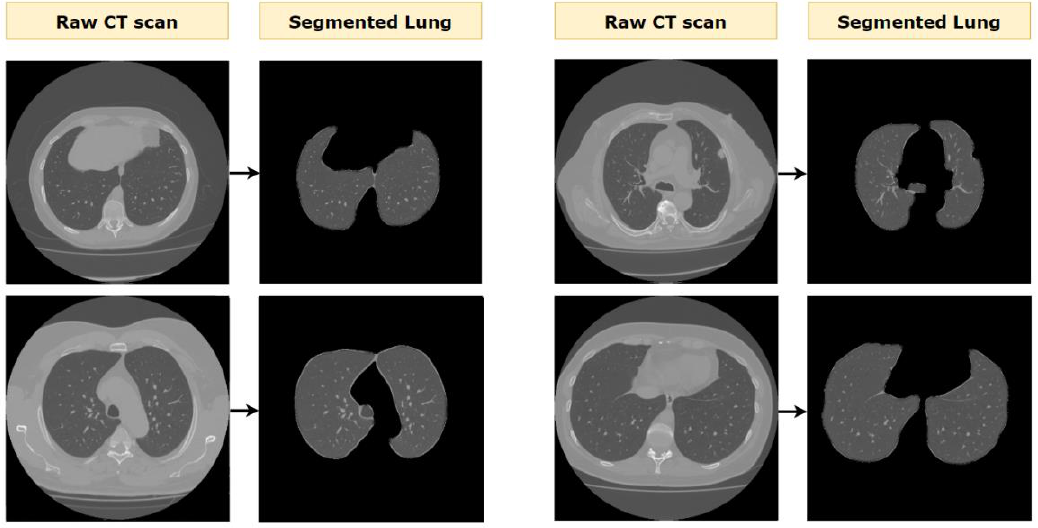
Figure 18. Example outcomes of the lung segmentation process.